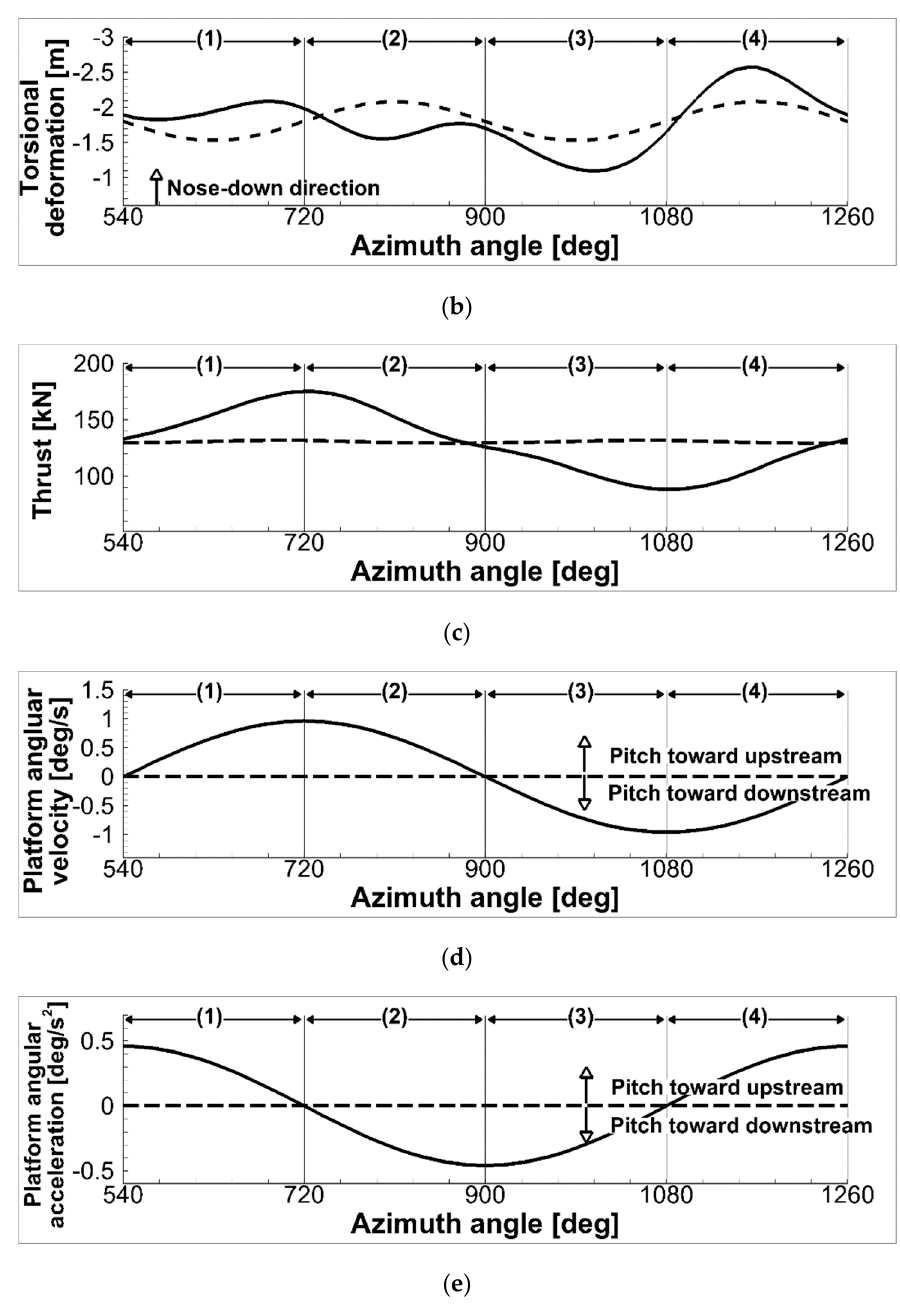
Figure 15. Blade aerodynamic loads and aeroelastic responses for one period of platform pitch motion. ( a ) Flapwise deformation at the blade tip. ( b ) Torsional deformation at the blade tip. ( c ) Thrust force of the reference blade. ( d ) Angular velocity of the platform in pitch motion. ( e ) Angular acceleration of the platform in pitch motion.